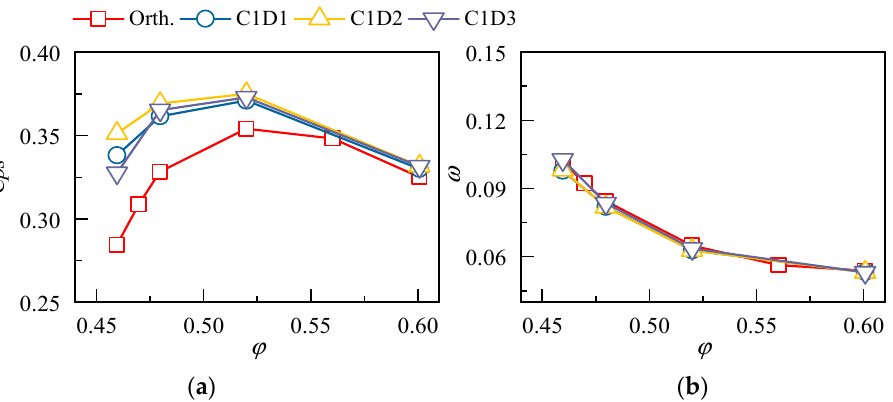
Figure 20. Pressure rise and loss characteristics for the stator with different dihedral angles. ( a ) Pres- sure rise and ( b ) loss.